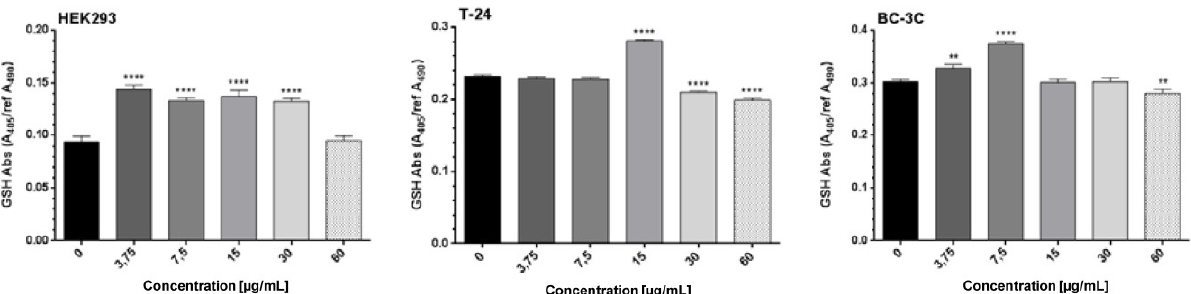
Figure 3. Reduction in GSH after treatment of HEK293, T-24 and BC-3C cell lines with EtOAc-AP extract of G. urbanum . The asterisks above the columns denote the p -value from the statistical analysis with one-way ANOVA obtained by comparison with the untreated control—** p < 0.01, **** p < 0.0001.